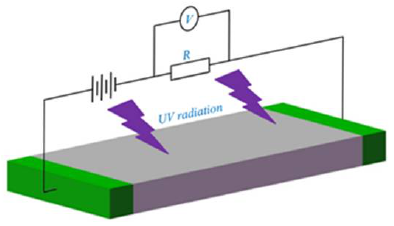
Figure 4. The operation of a photoconductor.